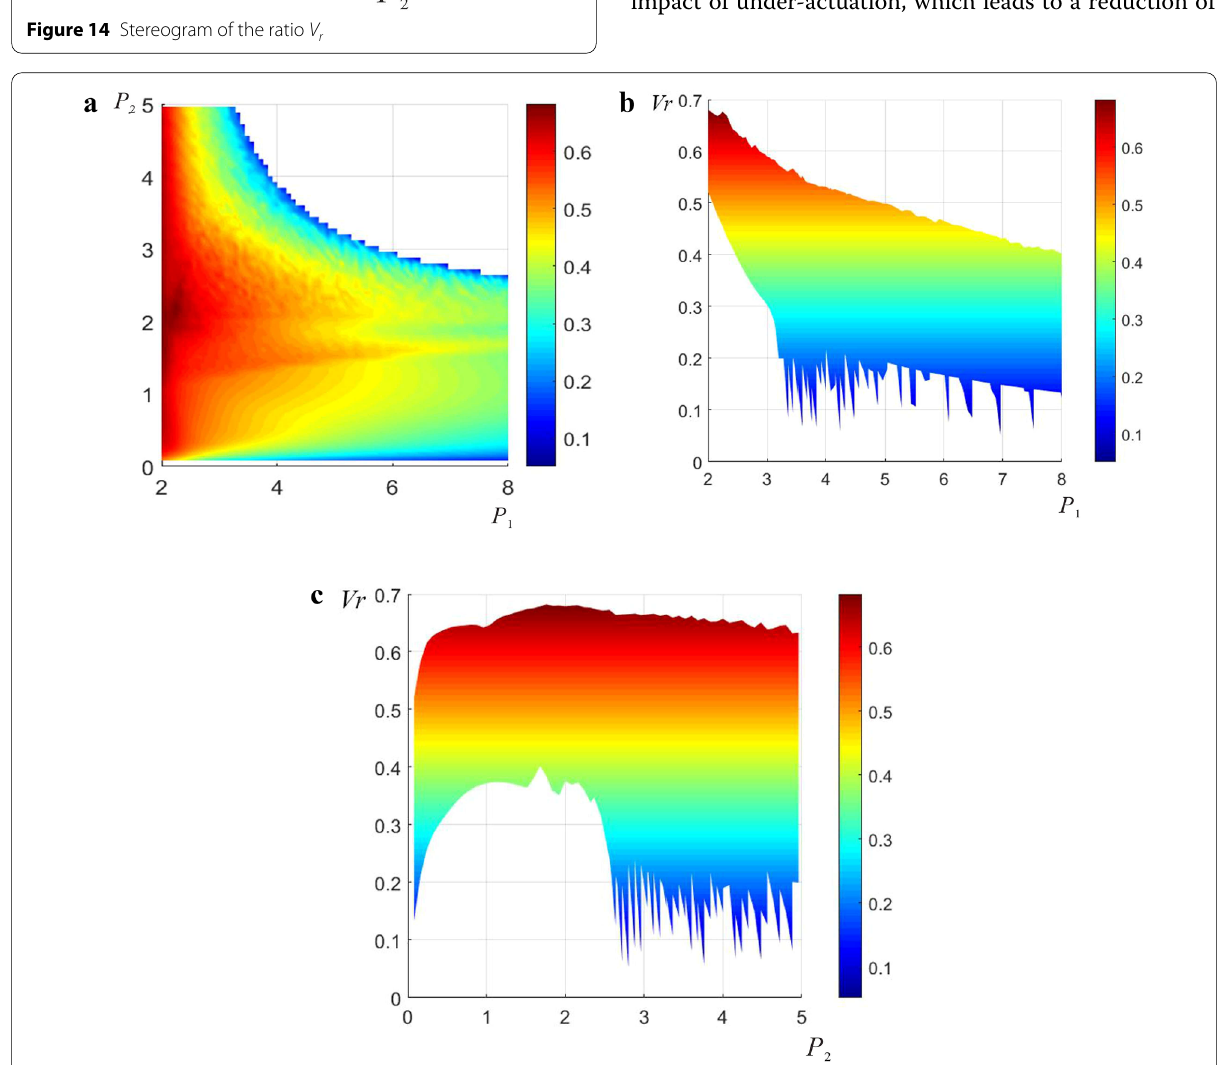
Figure 15 V r projection: a on the xOy plane, b on the zOx plane, and (c) on the yOz